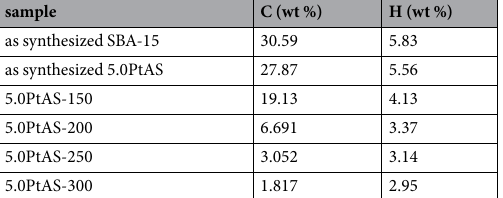
sample C (wt %) H (wt %)